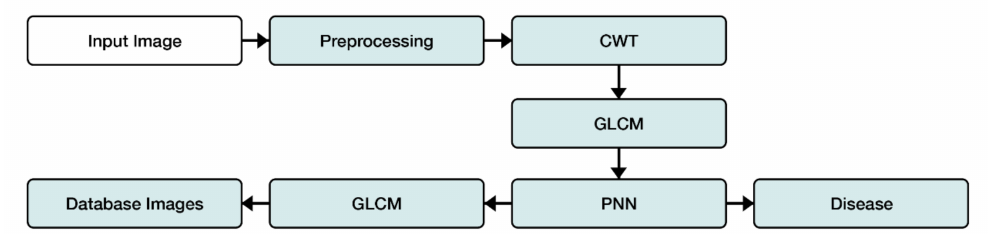
Figure 21. Block diagram of proposed methodology.